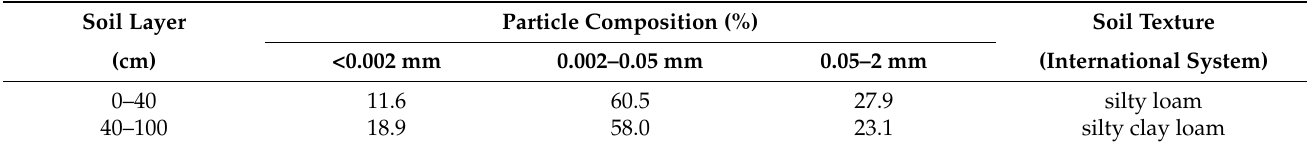
Table 9. The physical properties of soil in the experimental site.